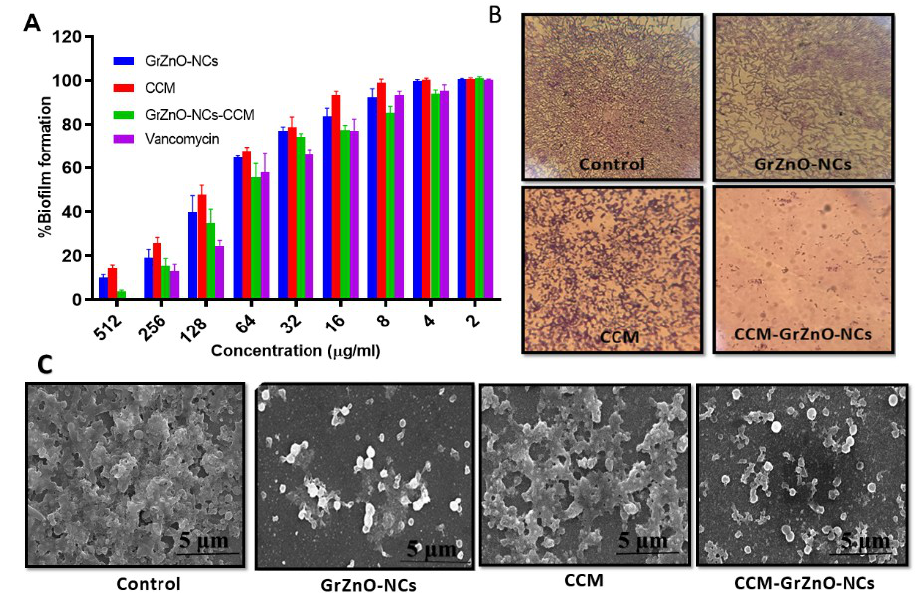
Figure 6. E ff ect of CCM-GrZnO-NCs various formulations against M.R.S.A. biofilm ( A ). E ff ect of GrZnO-NCs against biofilm development in MRSA ATCC 43300 strain. Growth inhibition was assessed by comparing relative metabolic activity (R.M.A.) determined using X.T.T. assay; the untreated group served as control showing 100% activity. Experiments were performed in triplicates, and results are shown with mean ± S.D. ( B ) Crystal violet staining of M.R.S.A. biofilm and ( C ) S.E.M. observation of the MRSA ATCC 43300 biofilm upon exposure to GrZnO-NCs